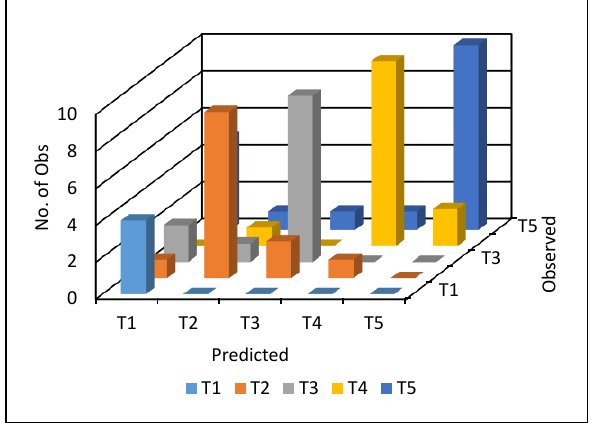
Figure 6. Classification Matrix for GBM Model using Full